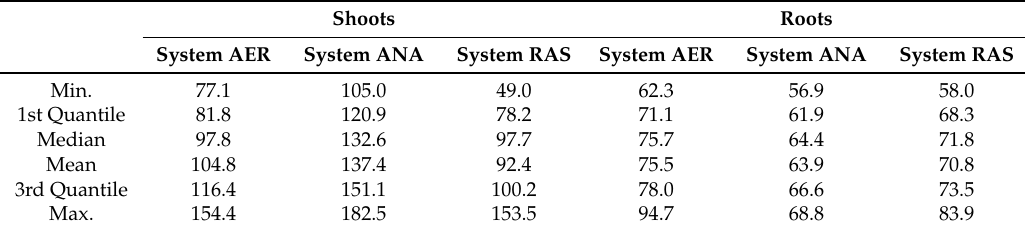
Figure 7. Lettuce root fresh weight in the aerobic (AER), anaerobic (ANA), and RAS systems after 35 days. Different letters indicate significant differences (Tukey ′ s HSD, n = 12, p < 05). Descriptive statistical data of this box plot can be found in Table 3. Table 3. Descriptive statistical data for shoot and root fresh weight in g.